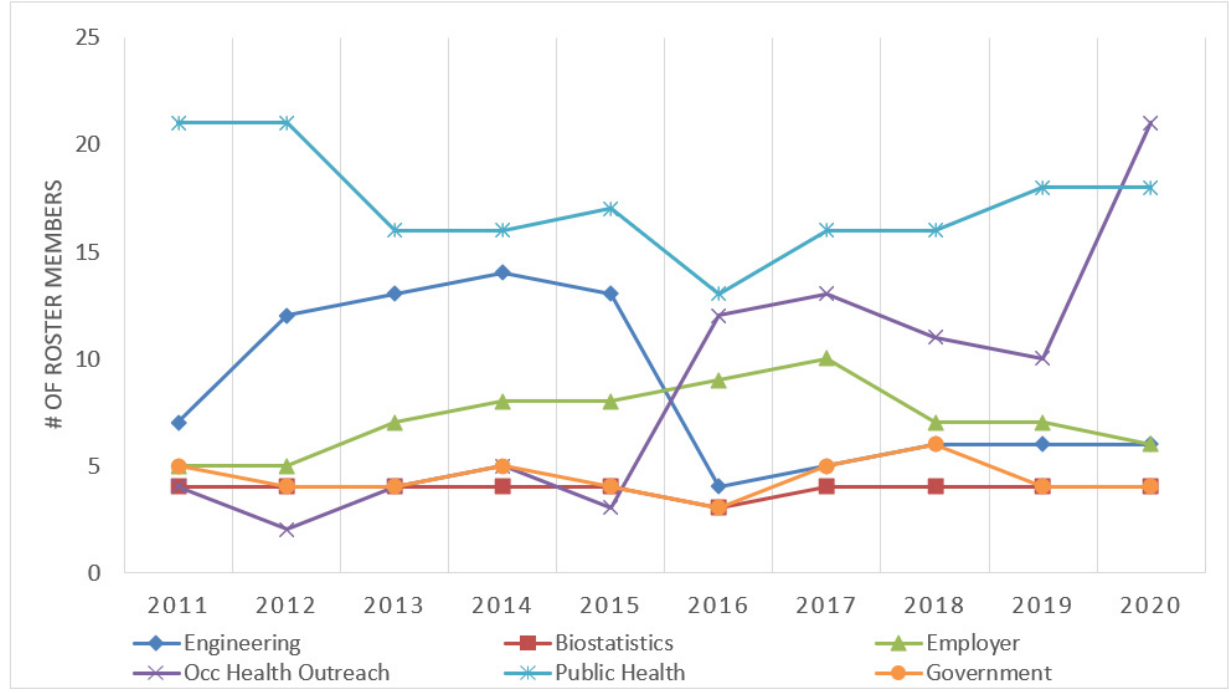
Figure 1. Representation of disciplines by year in the NEC SNA, 2011–2020 (not all disciplines represented due to limited sample size).